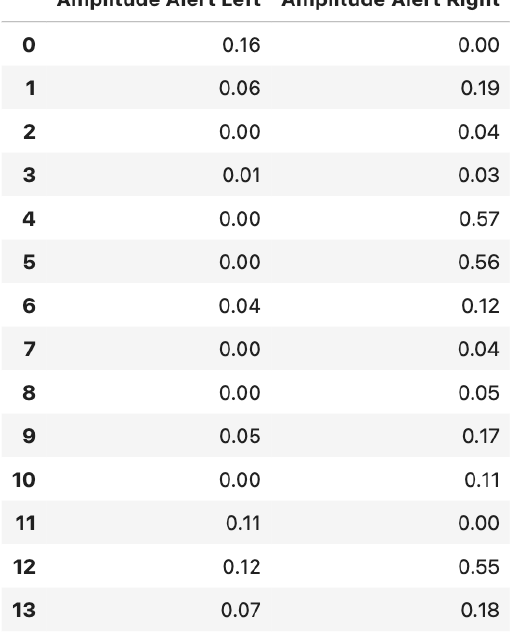
Figure 10. Alerts (fractions) for the amplitude for each participant for the combined data.